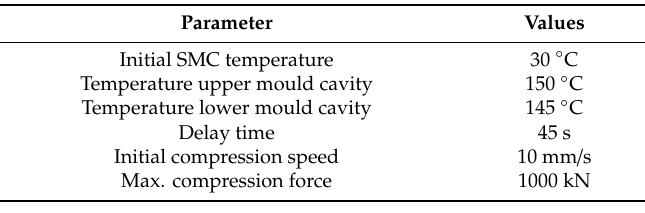
Table 2. Process settings [59]. SMC: Sheet Moulding Compounds.